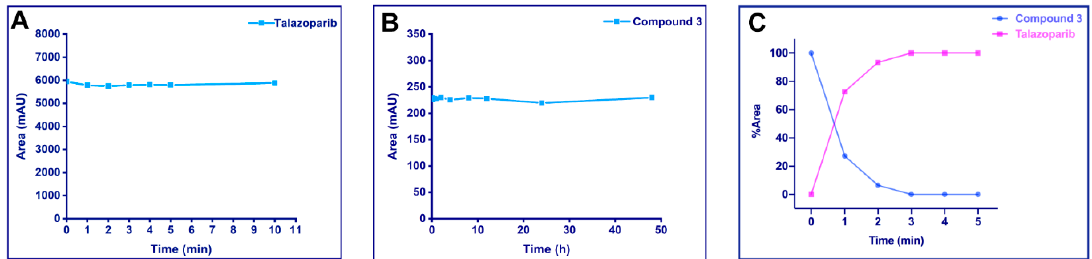
Figure 3. Stability assays and UV cleavage test in vitro. Compounds were irradiated at 365 nm (4.1 mW/cm 2 ). Samples were determined on a C18 column using a water/acetonitrile (ACN) gradient. The detection wavelength for high-performance liquid chromatography (HPLC) analysis was 220 nm. The peak area or peak area percentage was plotted against the irradiation time. ( A ) UV stability of Talazoparib: 2.63 mM Talazoparib in methanol were irradiated up to 10 min, and aliquot samples at different time points were analyzed by HPLC. Talazoparib was stable under the described UV irradiation. ( B ) Phosphate-buffered saline (PBS) stability of the photoactivatable prodrug: 20 μ M compound 3 in pH = 7.4 PBS (containing 10% DMSO) were incubated at 37 °C for 48 h and analyzed by HPLC. The peak area of compound 3 did not show significant changes. ( C ) UV cleavage test on compound 3 : 20 µ M of the compound in methanol was irradiated at 365 nm for 5 min and analyzed by HPLC. By progressing irradiation, compound 3 was converted into